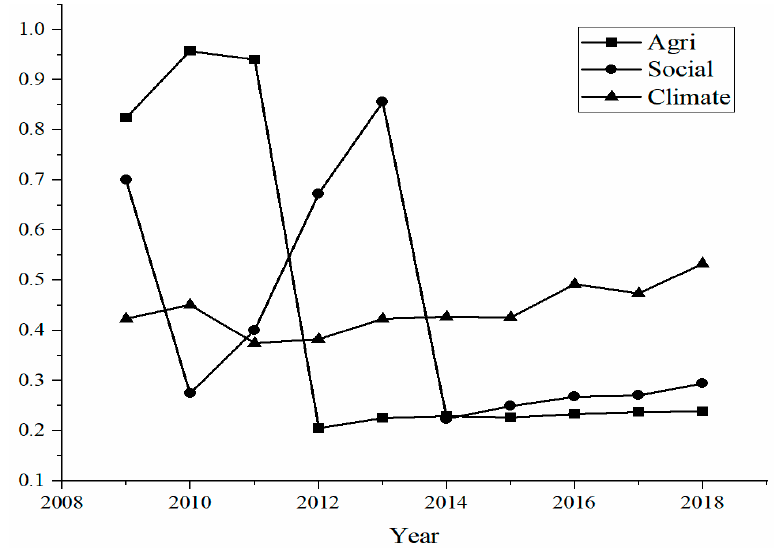
Figure 2. Average of the 3 s ubsystems of APLE in the HREB from 2009 to 2018.